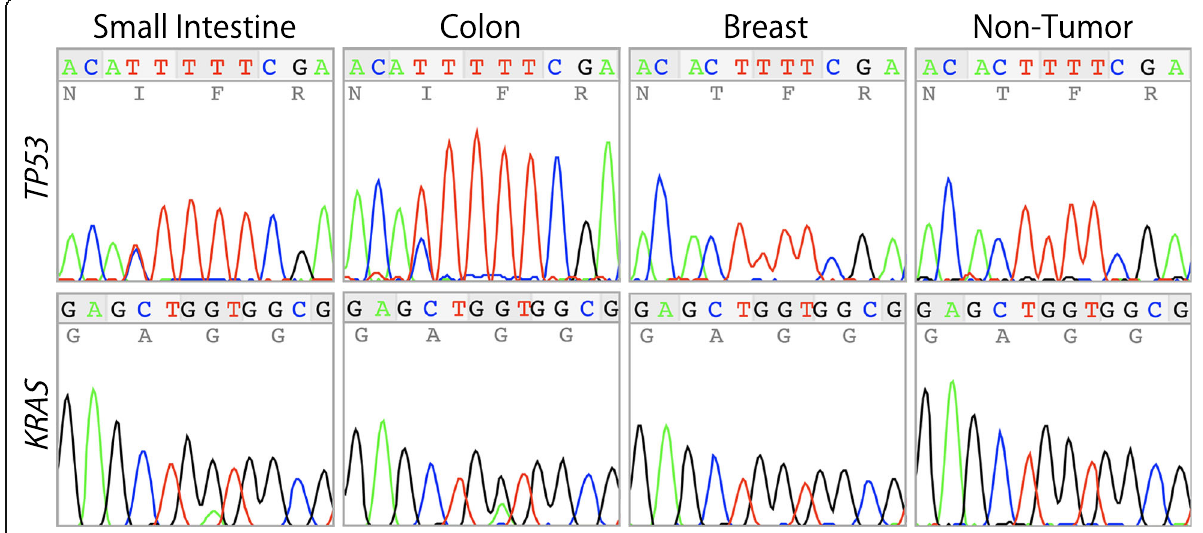
Fig. 6 Genetic analyses of the present case. A DNA sequence analysis of TP53 exon 6 (upper panels) and KRAS exon 2 (lower panels) from the small intestinal, colon, and breast carcinoma lesions and normal intestinal tissue (non-tumor). In the sequences of colon and small intestinal carcinomas, missense mutations were detected at c.632C > T in the TP53 gene and at c.35G > A in the KRAS